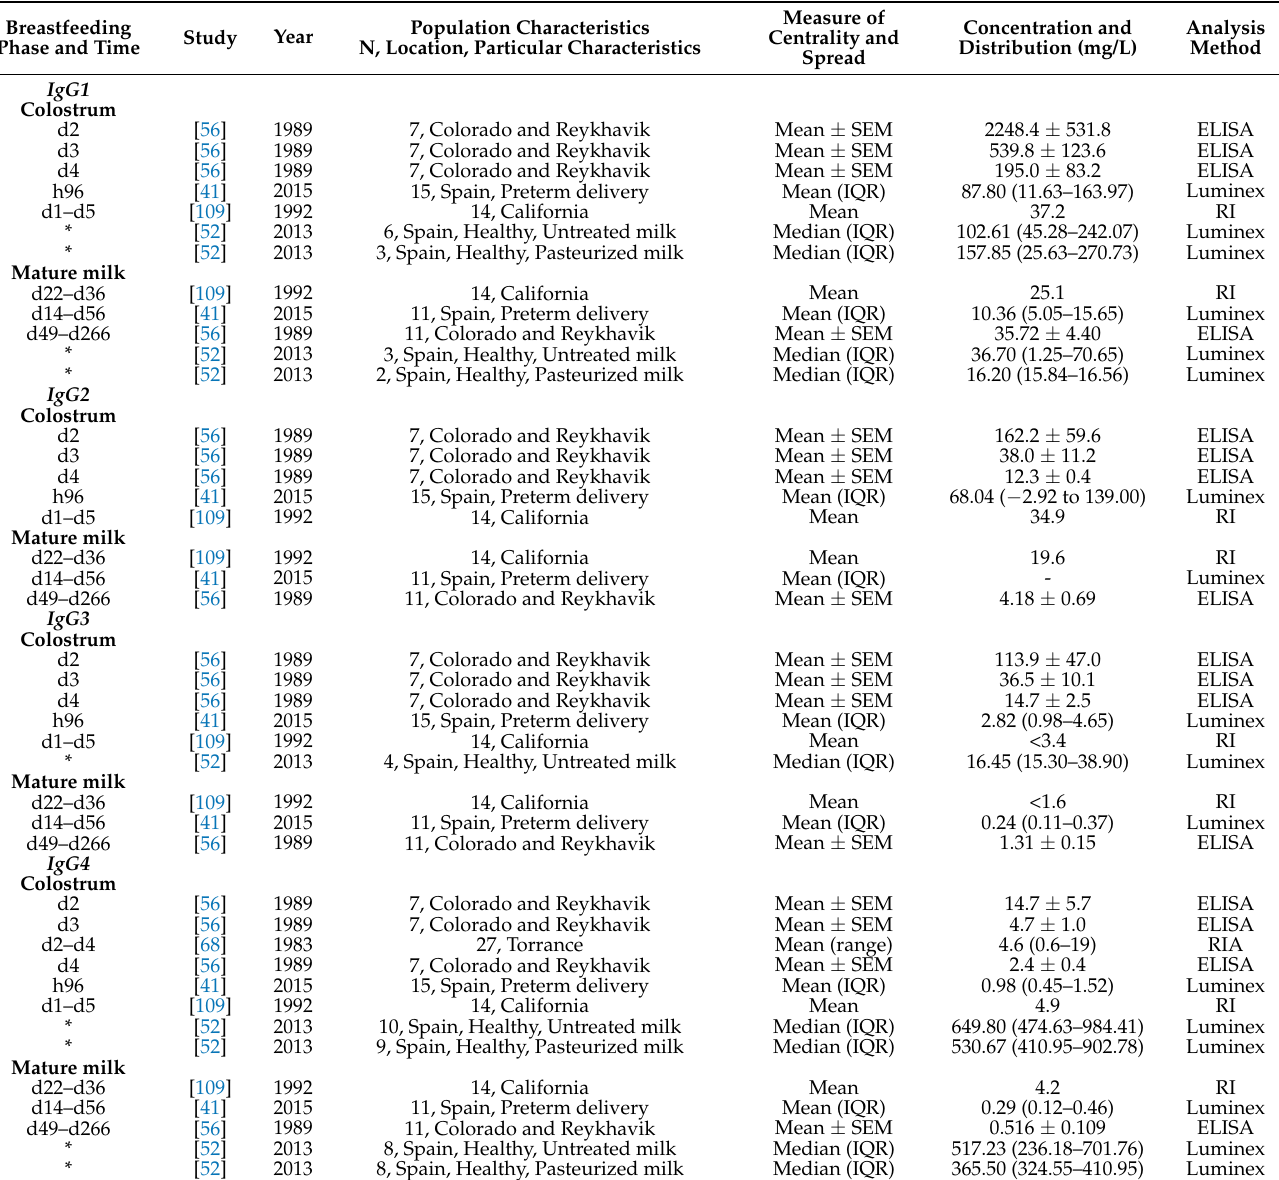
Table 6. IgG subtypes in